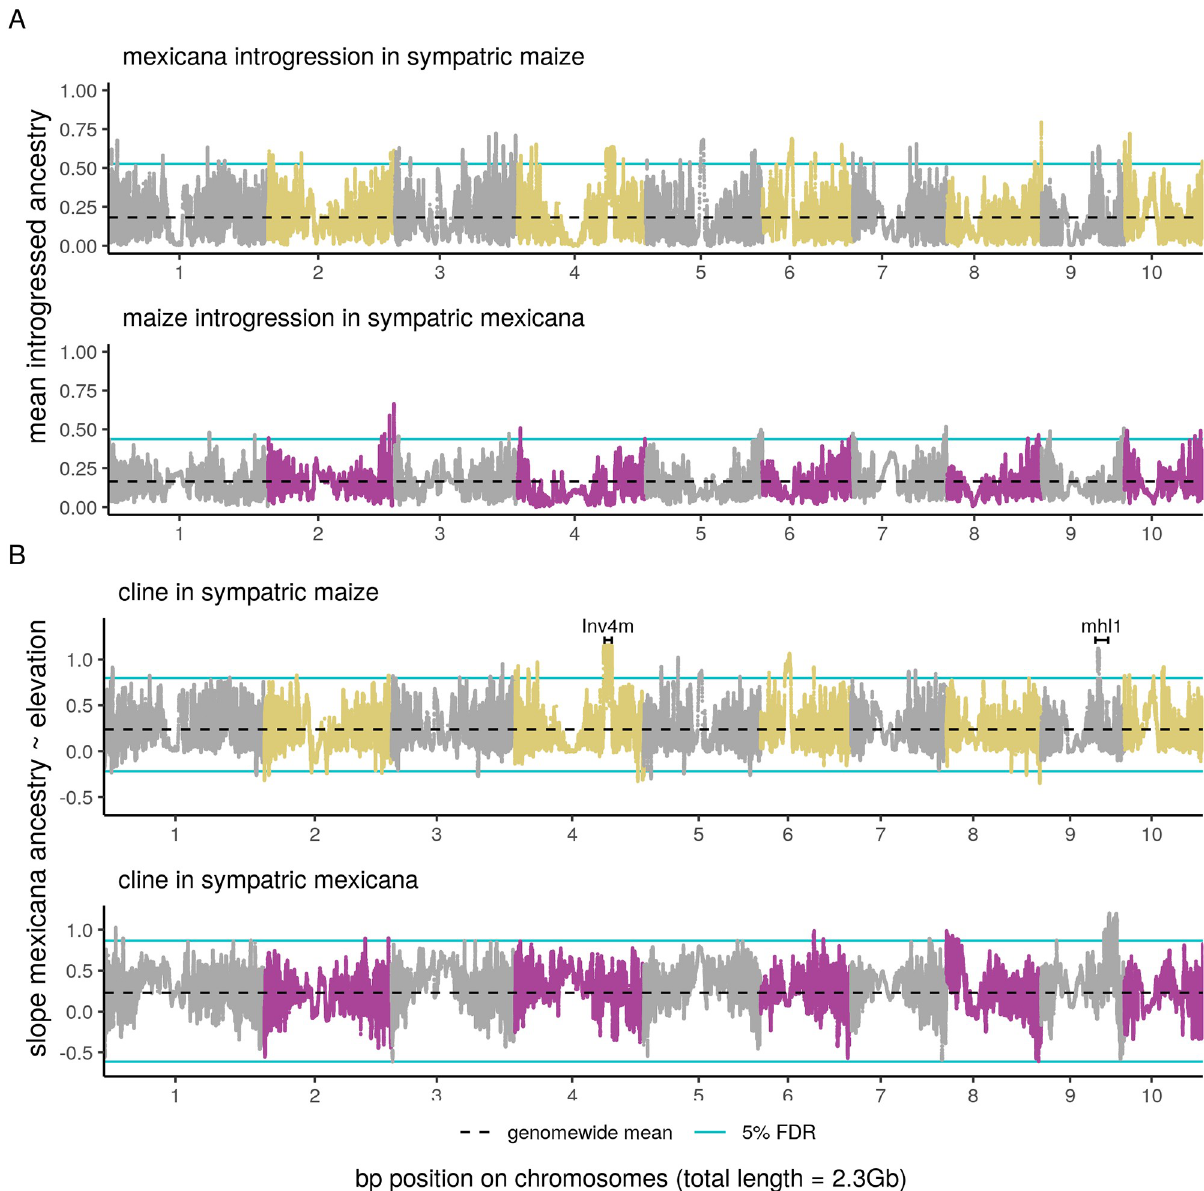
Fig 7. Genomewide scan for selection on introgressed ancestry. (A) Mean mexicana ancestry introgressed into sympatric maize populations and mean maize ancestry introgressed into sympatric mexicana populations. (B) Slope of mexicana ancestry proportion over a 1 km elevation gain in sympatric maize and mexicana populations. In both (A) and (B) the blue lines show the 5% false discovery rates, set using multi-variate normal simulations. Positions for Inv4m [50] and the mhl1 locus [65] were converted to the maize reference genome v4 coordinates using Assembly Converter (ensembl.gramene.org). Chromosome numbers are placed at the centromere midpoint (approximate centromere positions are from [66]).